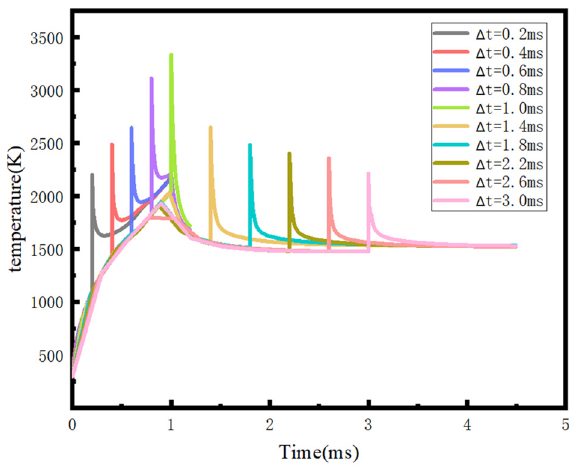
Figure 2. Variation in fused quartz temperature with time under different pulse delay